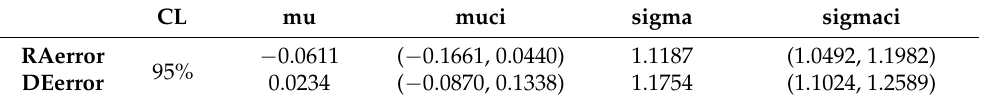
Figure 7. ( a ) Probability distribution of RA error . ( b ) Probability distribution of DE error . Table 4. Analysis of the probability distribution for the positioning